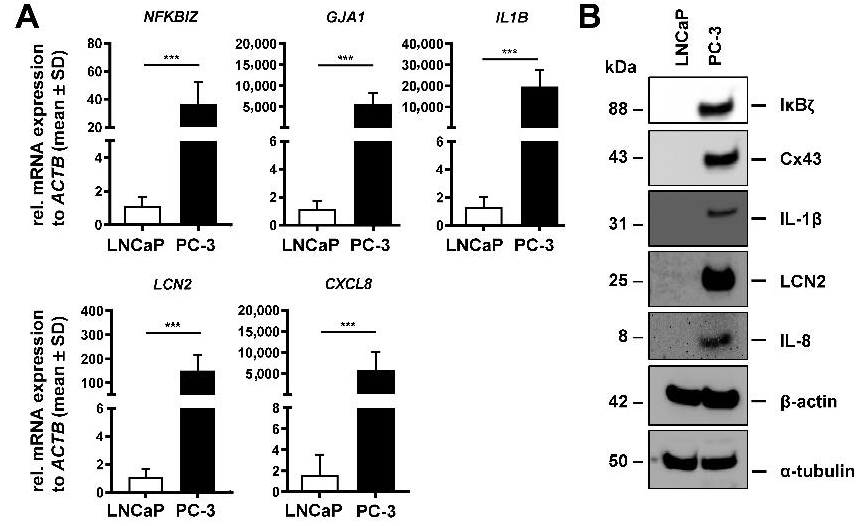
Figure 1. LCN2 and other tumorigenic markers in human prostate cancer cell lines. The human prostate cancer cell lines LNCaP and PC-3 were analyzed for mRNA or protein expression after culturing under basal conditions. ( A ) Quantitative mRNA analysis of NFKBIZ, GJA1, IL1B, LCN2, and CXCL8 in both cell lines revealed significantly higher expression levels in PC-3 cells (n = 4). Relative mRNA expressions were normalized to ACTB expression and values are given in relation to LNCaP cells. Significant differences between LNCaP and PC-3 cells are indicated as *** p < 0.001. ( B ) Western blot analysis confirmed lower protein expression of these markers in LNCaP cells (n ≥ 3). β-actin and α-tubulin expression served as internal loading controls.